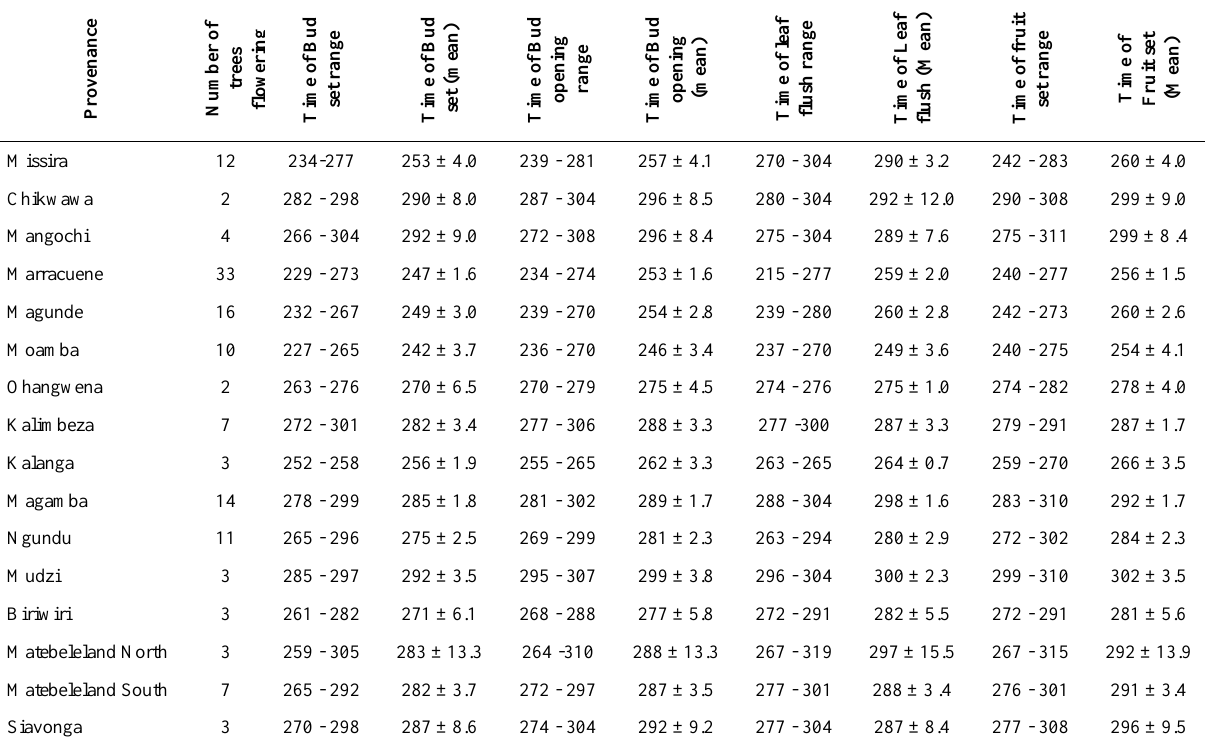
Table 2. Number of flowering trees, time of bud set, bud opening, leaf flush and fruit set (Mean and range) ± Standard error ce n n a m ov e u N P r